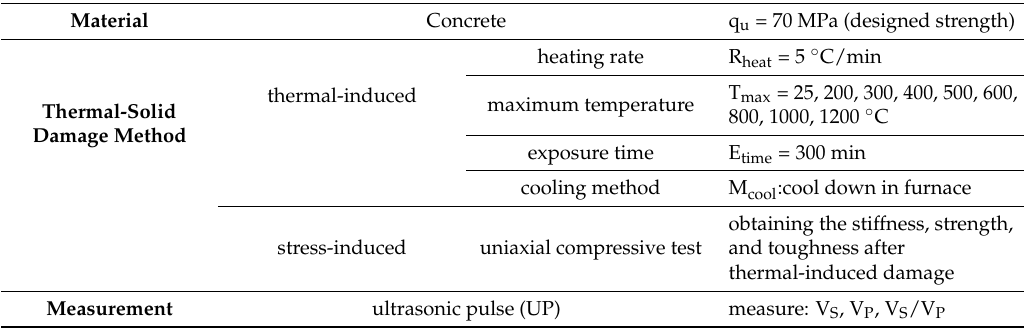
Table 1. Experimental conditions and measurement.